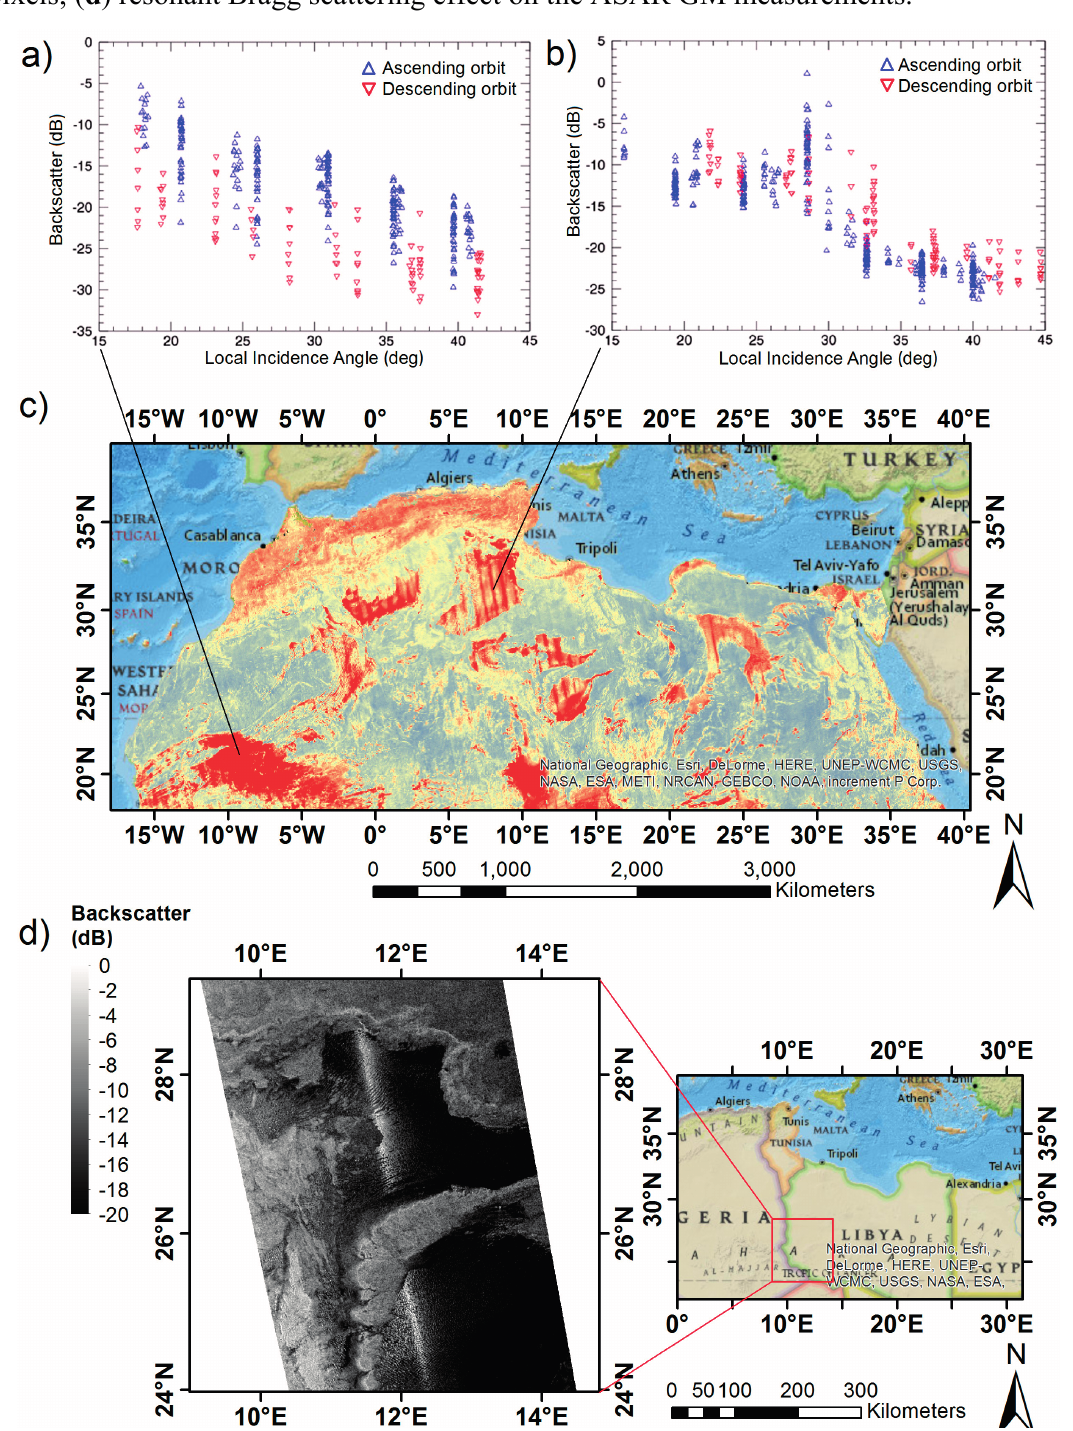
Figure 10. The relationship between the measured backscatter and the local incidence angle illustrating problems in desert environments: ( a ) dependency of the backscatter value on the azimuth angle and, therefore, on orbit direction (ascending or descending); ( b ) Bragg scattering from sandy dunes at around a 30-degree incidence angle; ( c ) locations of the plotted Advanced Synthetic Aperture Radar (ASAR) Global Monitoring (GM) pixels; ( d ) resonant Bragg scattering effect on the ASAR GM